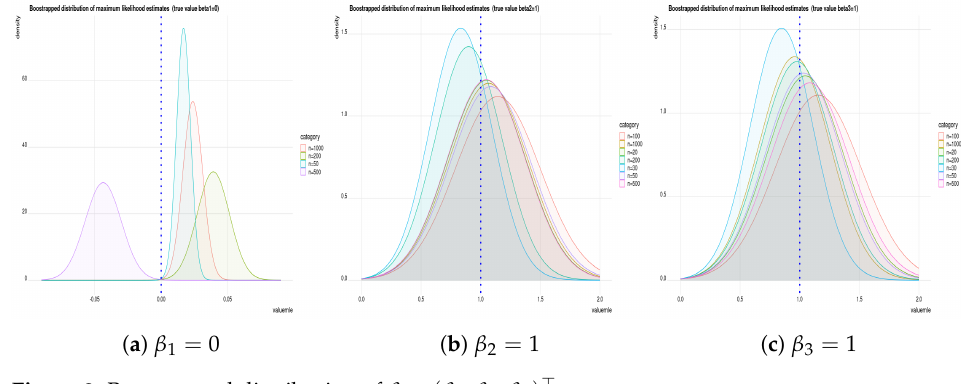
Figure 2. Boostrapped distribution of β = ( β 1 , β 2 , β 3 ) (cid:62) .